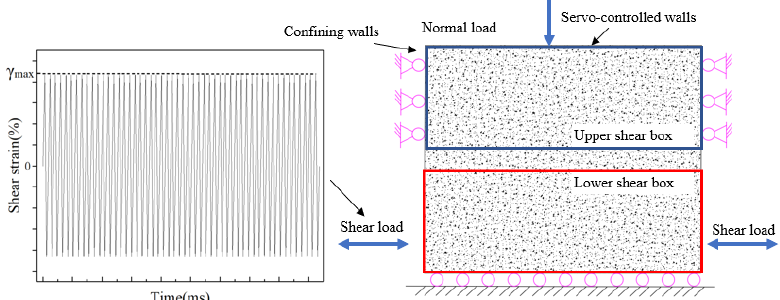
Figure 3. Schematic diagram of the cyclic loading process of the numerical model.